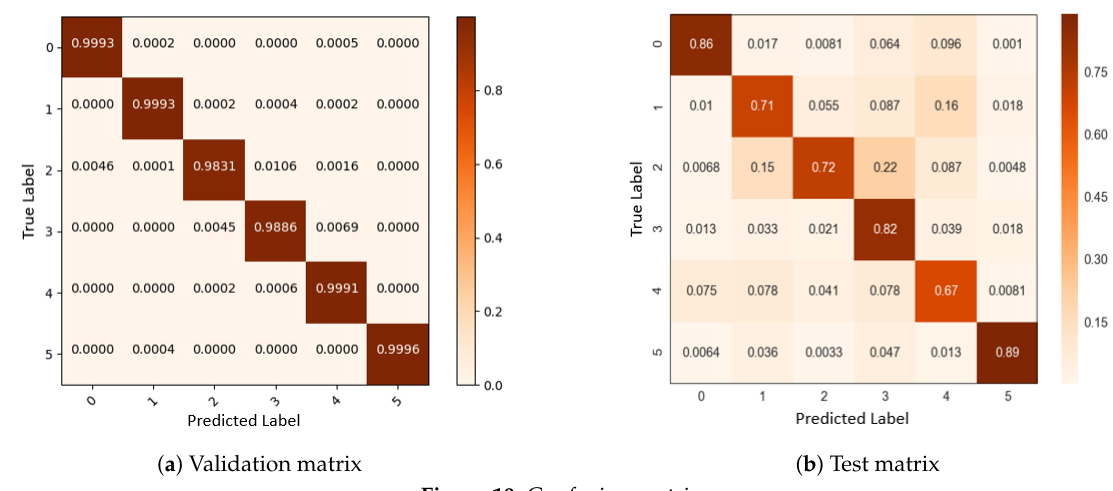
Figure 10. Confusion matrix.